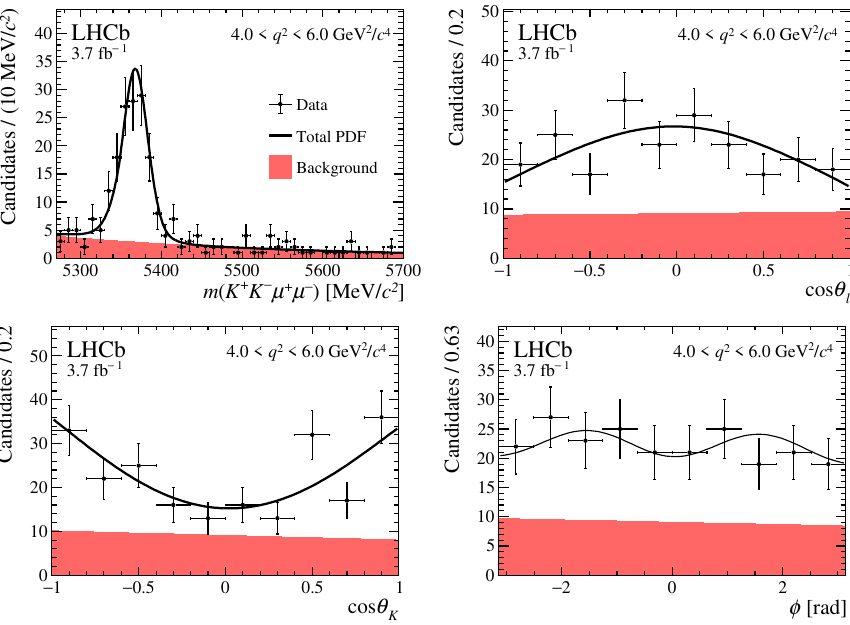
Figure 20 . Mass and angular distributions of B 0 4 . 0 < q 2 < 6 . 0 GeV 2 /c 4 for data taken in 2017–2018. The data are overlaid with the projections of the fitted PDF.